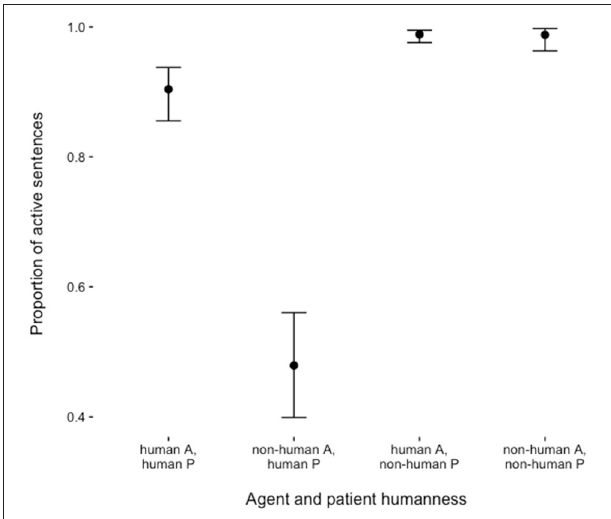
FIGURE 2 | Proportions of active sentences as a function of agent (A) and patient (P) humanness. Bars indicate 95% confidence intervals ( Agresti and